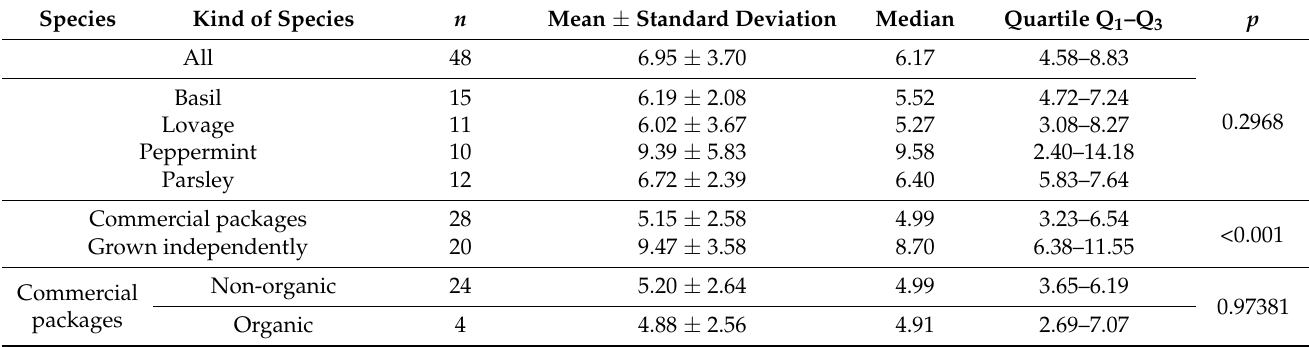
Table 2. Hg concentration in the tested spice plants, µ